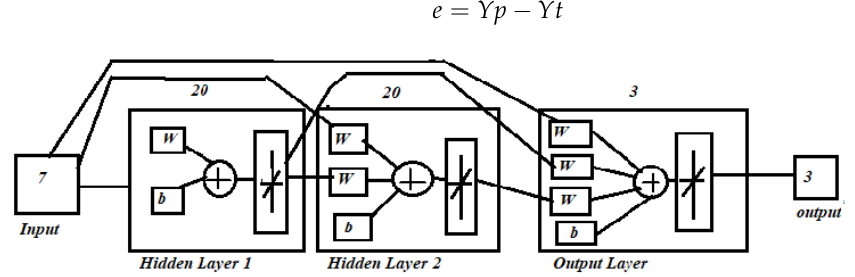
Figure 4. Architecture of artificial neural network.